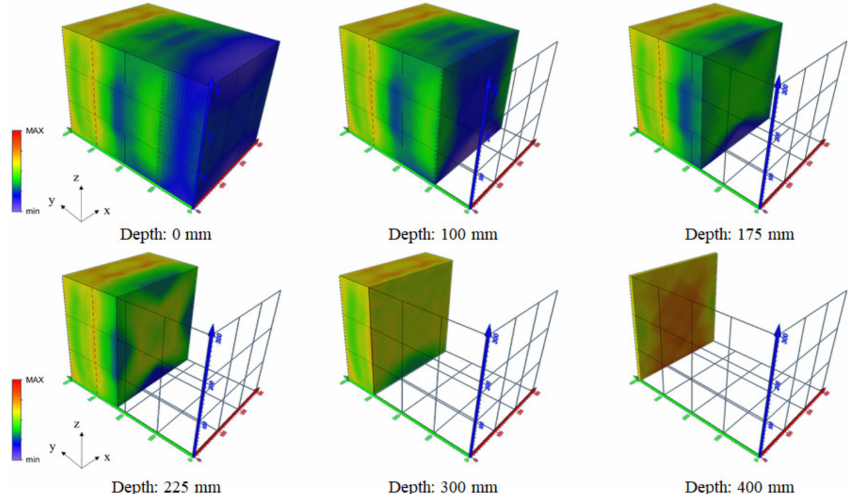
Figure 14. Result of 3D SIBIE procedure for damage-simulated concrete